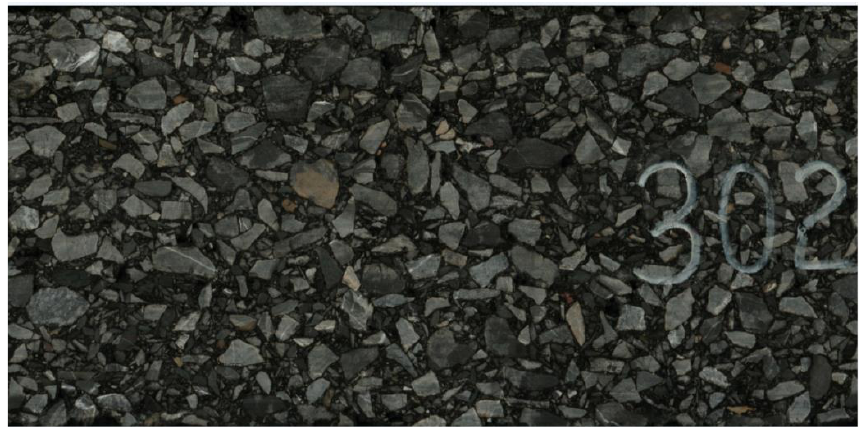
Figure 3. Scanned image of the asphalt mixture.